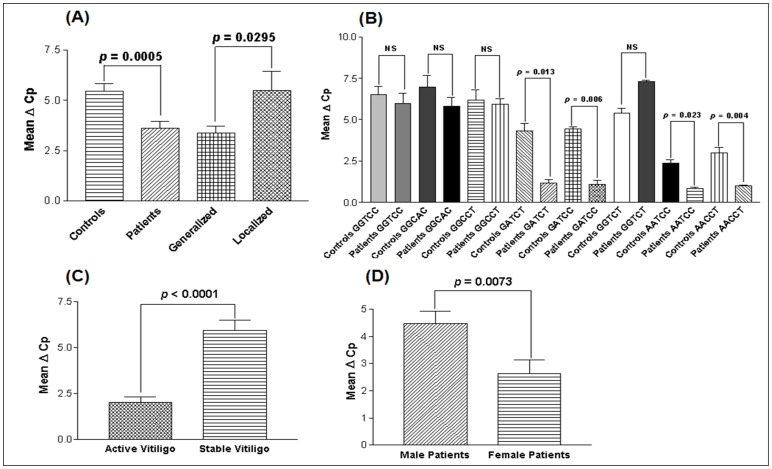
Relative gene expression of TNF-α in controls and vitiligo patients.(A) Expression of TNF-α transcripts in 174 controls, 157 vitiligo patients, 115 generalized vitiligo patients and 42 localized vitiligo patients, as suggested by Mean ΔCp. (B) Expression of TNF-α transcripts with respect to TNF-α promoter haplotypes in 157 vitiligo patients and 174 controls, as suggested by Mean ΔCp. (C) Expression of TNF-α transcripts with respect to activity of the disease in 108 patients with active vitiligo and 49 patients with stable vitiligo, as suggested by Mean ΔCp. (D) Expression of TNF-α transcripts with respect to gender differences in 68 male patients and 89 female patients with vitiligo, as suggested by Mean ΔCp.